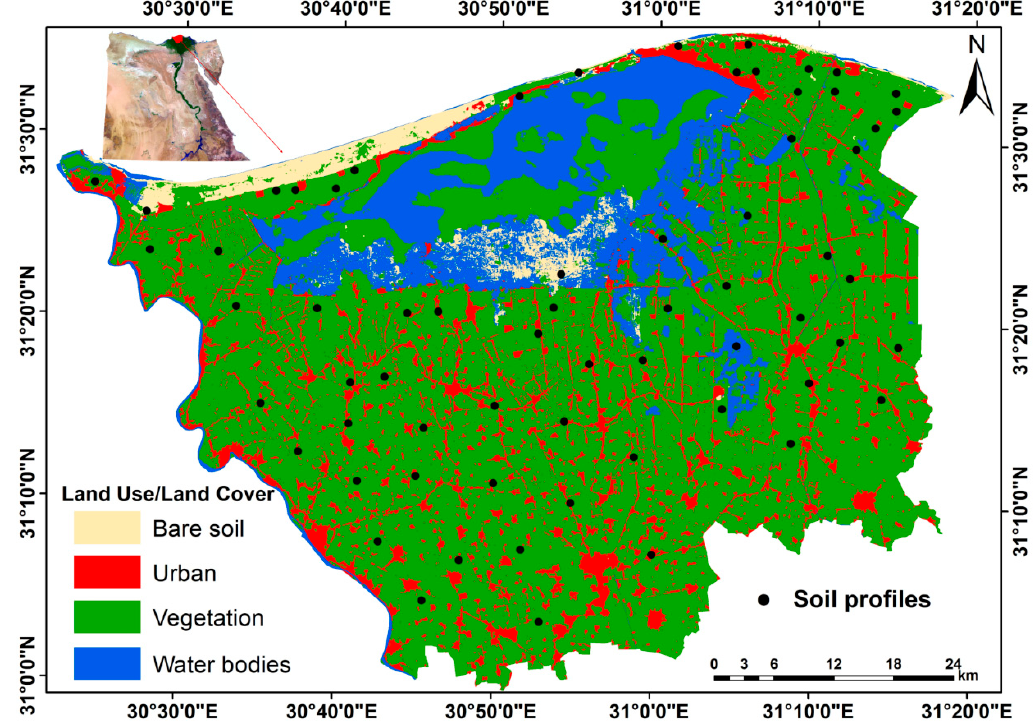
Figure 1. Location map of the study area.